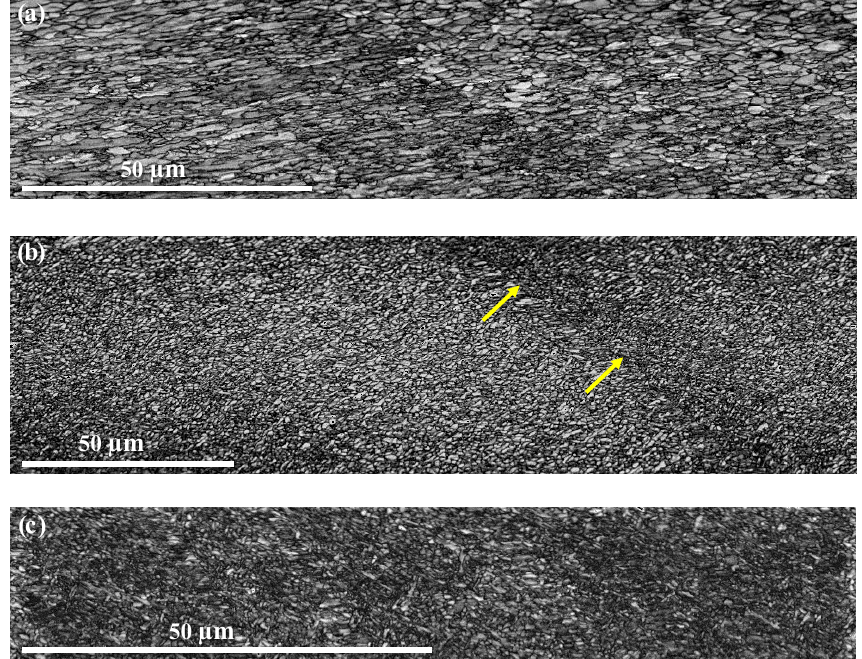
Figure A9. EBSD band contrast images taken along a cross section from different parts of the shell of pristine Arctica islandica . (a) Outer shell layer, (b) central shell section, and (c) inner shell layer. Well visible is the difference in crystallite size. In contrast to the outer shell layer (a) , the innermost shell section is highly dense and consists of minute aragonite crystals.